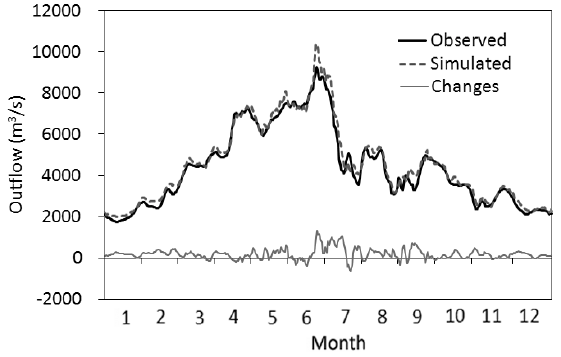
Figure 7. Comparison of observed and simulated lake outflow during 2000–2011.